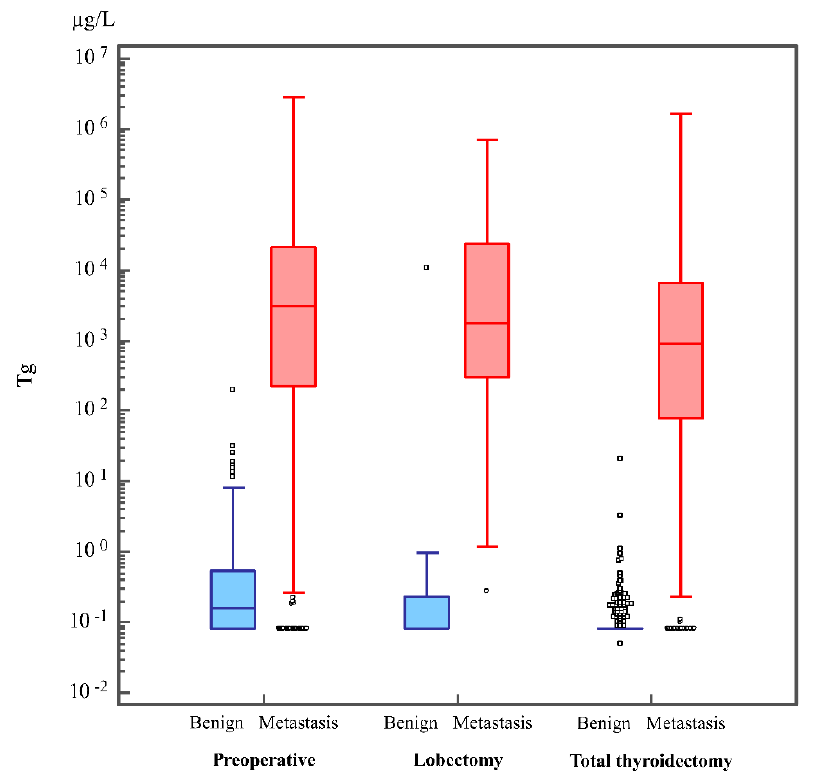
Figure 1. The distribution of FNA-Tg in benign and metastatic LNs obtained preoperatively, after lobectomy, and after total thyroidectomy. Boxplots represent median (line within box), 25th percentile (lower hinge) and its lower adjacent value (lower adjacent line), 75th percentile (upper hinge) and its upper adjacent value (upper adjacent line), and outside values (dots). FNA, fine-needle aspiration; LN, lymph node; Tg, thyroglobulin.